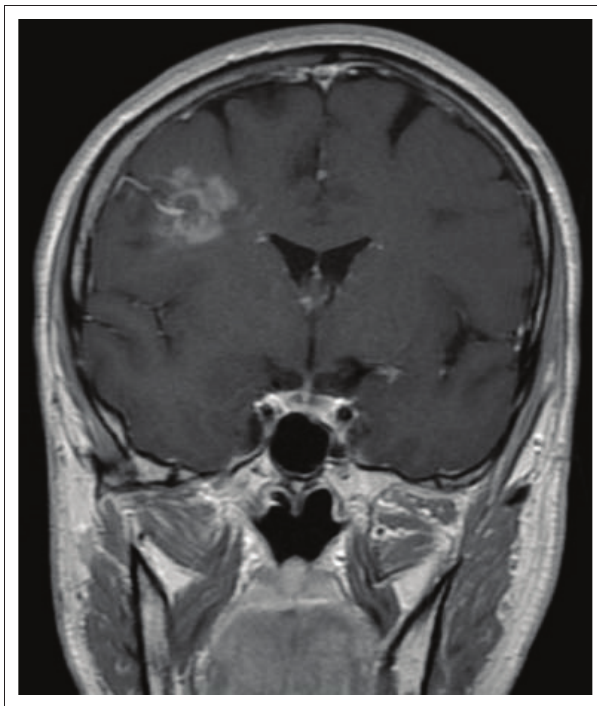
FIGURE 4: Coronal post-contrast T1-weighted MR